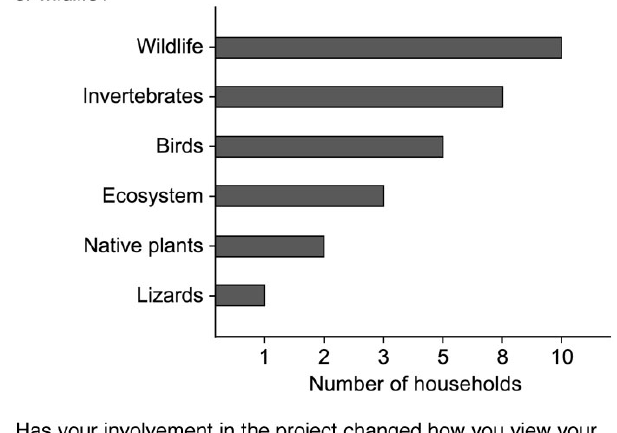
Fig. 1 . Frequency of garden householder responses to the questions